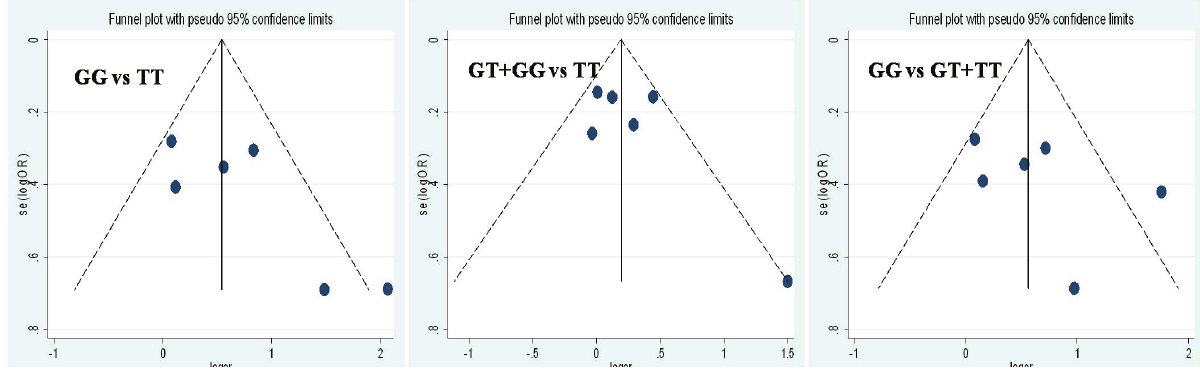
Figure 4: The begg’s funnel plot for evaluation publication